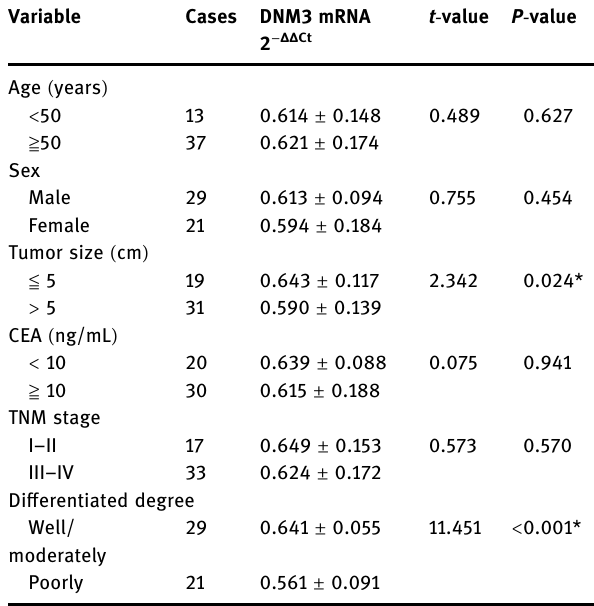
Table 2: Immunohistochemistry positive rates of DNM3 Rates CRC tissues Adjacent non - tumor tissues